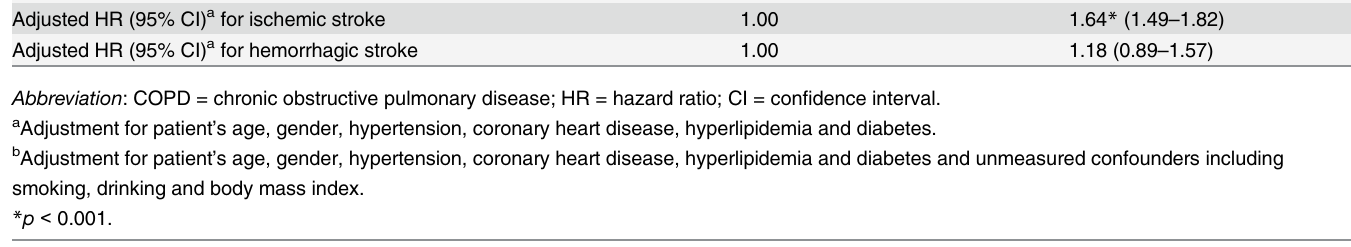
Abbreviation : COPD = chronic obstructive pulmonary disease; HR = hazard ratio; CI = con fi dence interval. a Adjustment for patient ’ s age, gender, hypertension, coronary heart disease, hyperlipidemia and diabetes. b Adjustment for patient ’ s age, gender, hypertension, coronary heart disease, hyperlipidemia and diabetes and unmeasured confounders including smoking, drinking and body mass